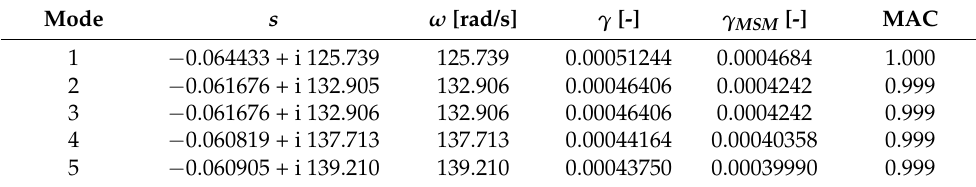
Table 7. Dome 2—NEP eigenvalues, natural frequency, non-dimensional damping ratio and MAC; data taken from